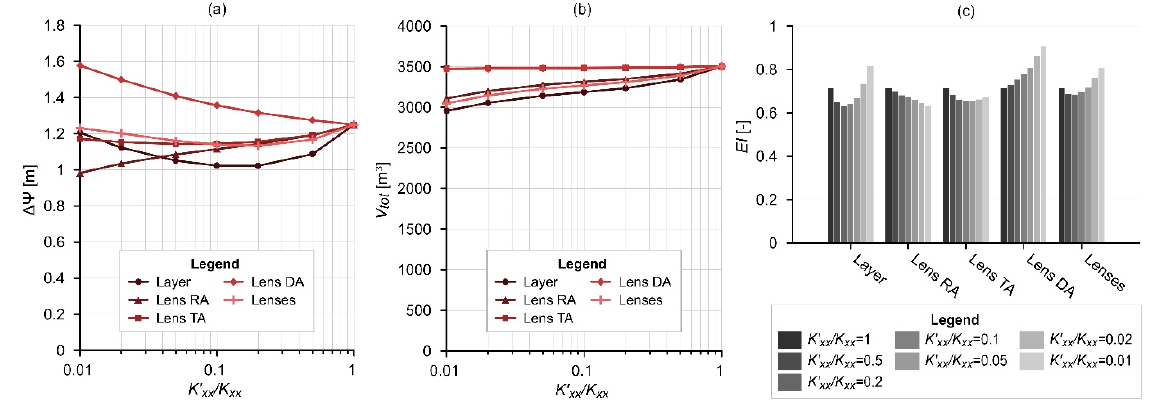
Figure 6. The effect of heterogeneity ( K’ xx /K xx ) on the water level increase ΔΨ —( a ), the cumulative water volume of infiltrating water V tot —( b ), and the Efficiency Index EI —( c ) after 5 years (SG ‐ 5).